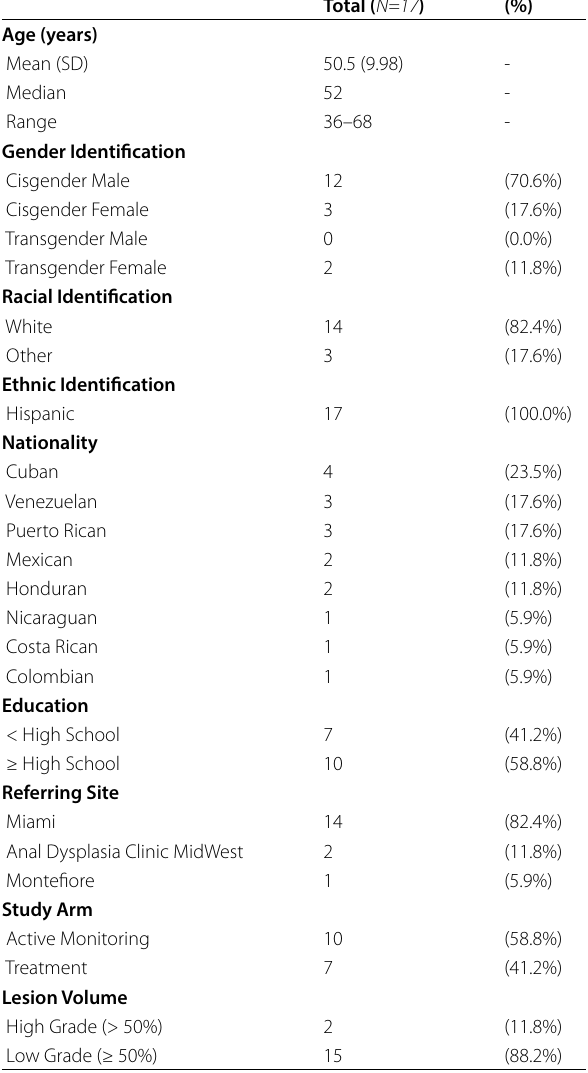
Table 1 Participant demographics and clinical